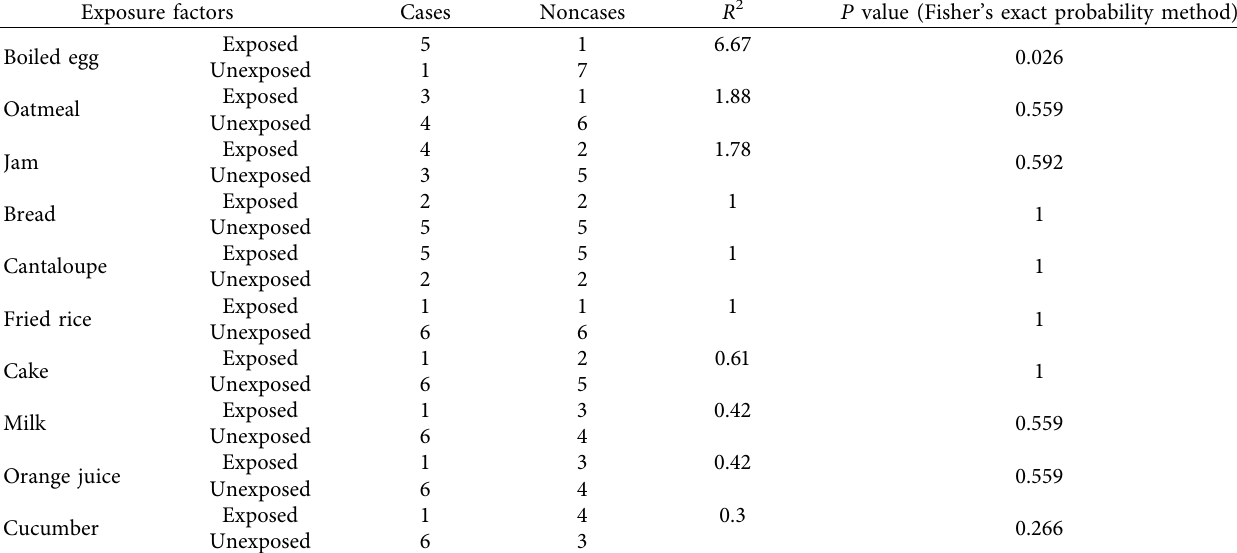
Table 5: Retrospective survey of food eaten for breakfast on May